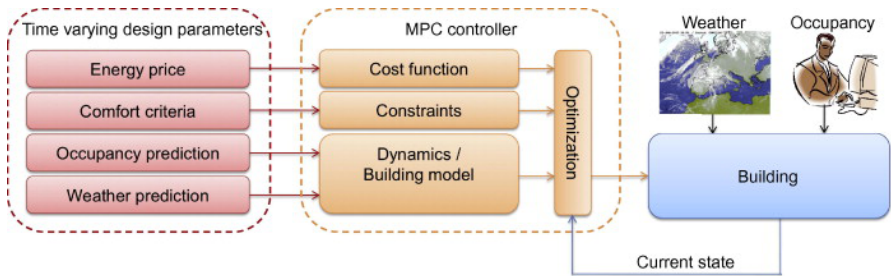
Figure 3. Basic principle of model predictive control for buildings